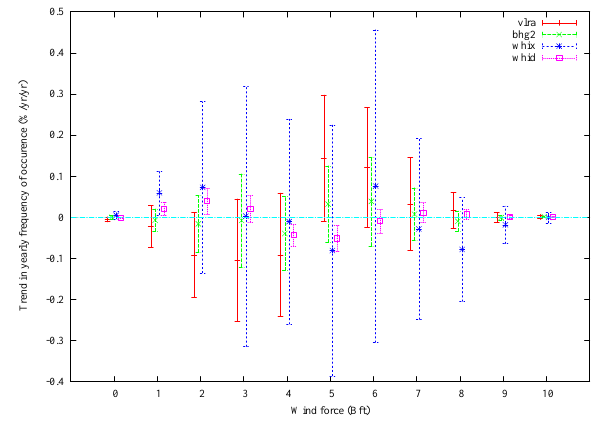
Figure 3: Trend in the yearly frequency of occurrence for the difference wind forces. vlra: Vlakte van de Raan; bhg2: Brouwershavensegat 2; whix: Westhinder; whid: Westhinder DNMI data. The error bars give the 95% confidence interval.